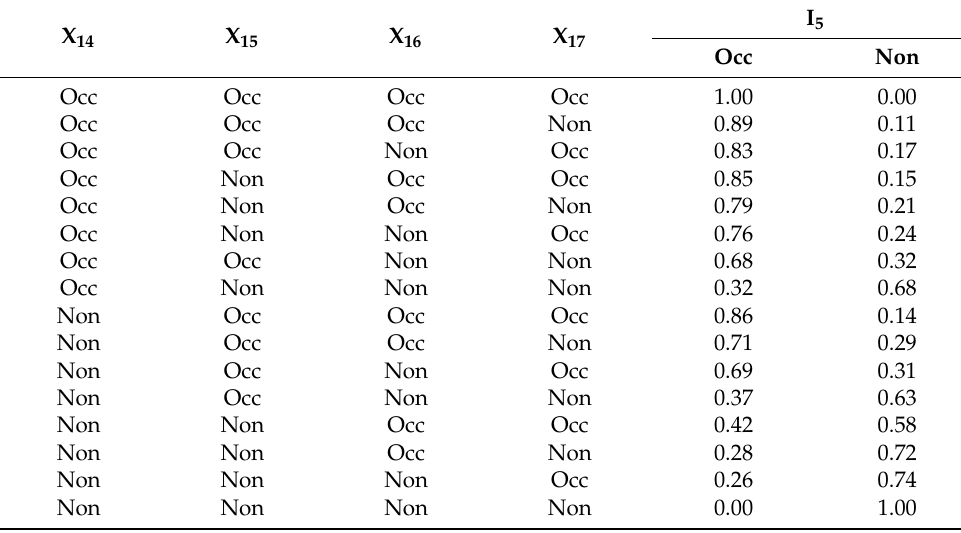
Table A4. The CPT of event I 5 (Too-low temperature; Occ: occurred; Non: